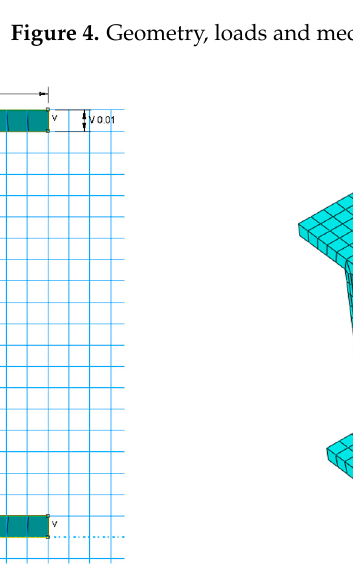
Figure 5. Cross-sectional dimensions (left graph) and beam meshing scheme (right graph).